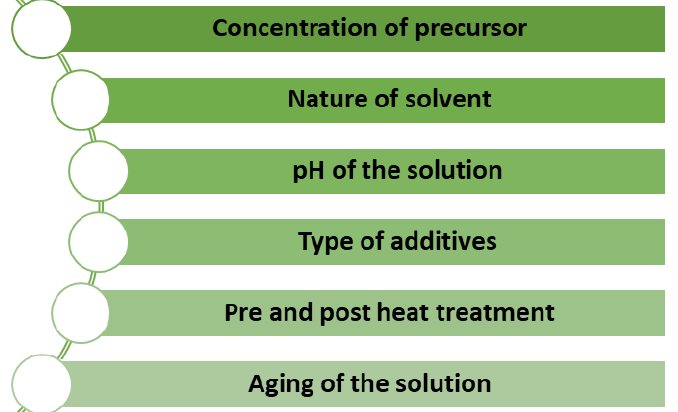
Figure 9. Factors for controlling unique MOX nanostructures by the sol–gel method.